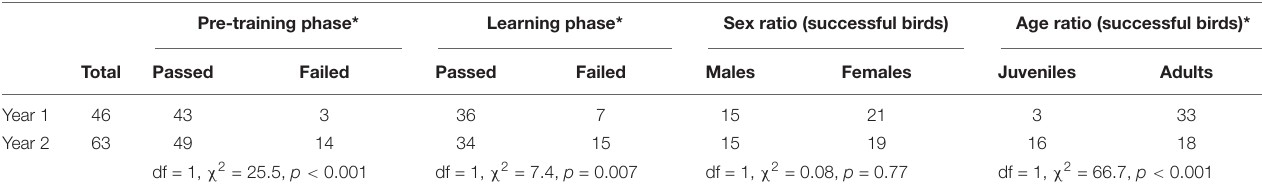
TABLE 1 | Comparison between Year 1 and Year 2 regarding number of caught birds, successful birds (Pre-training and Learning phase), sex ratio, and proportion of juveniles. Pre-training phase* Learning phase* Sex ratio (successful birds) Age ratio (successful birds)*